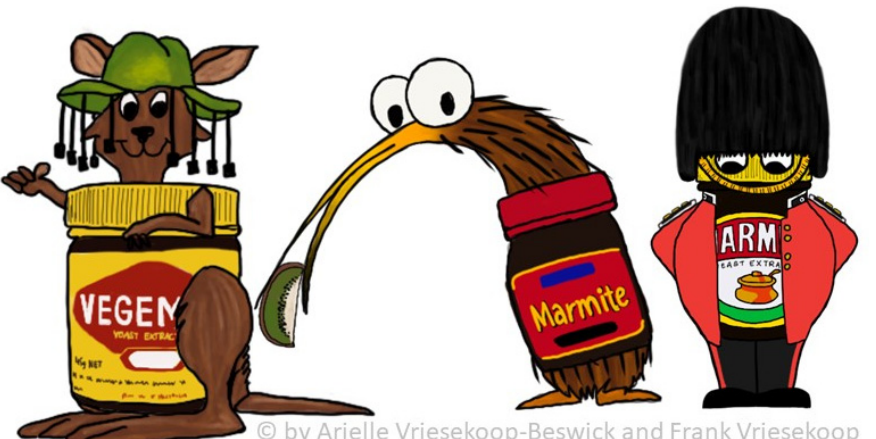
Figure 5. Iconisation of national yeast spreads. Australian Vegemite morphed with a kangaroo and a cork-slouch hat. New Zealand Marmite morphed with a kiwi bird and a slice of kiwi in its beak. British Marmite wearing a British Queen’s guard uniform represented by black pants, red tunic and bearskins (hat). Artwork by Ariëlle Vriesekoop-Beswick and Frank Vriesekoop.